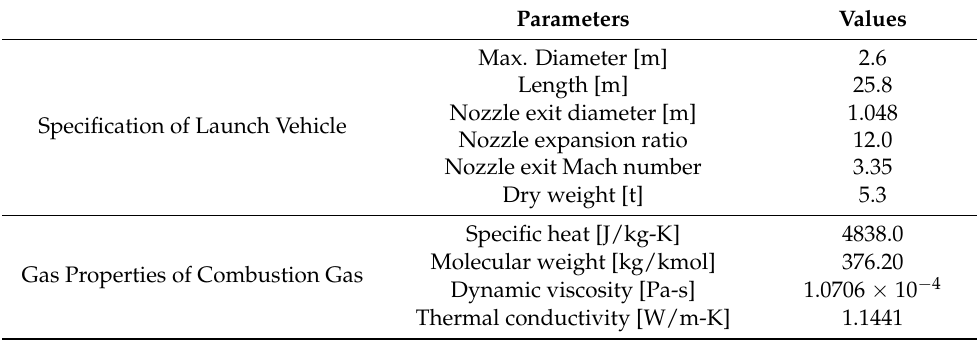
Table 2. Specification and gas